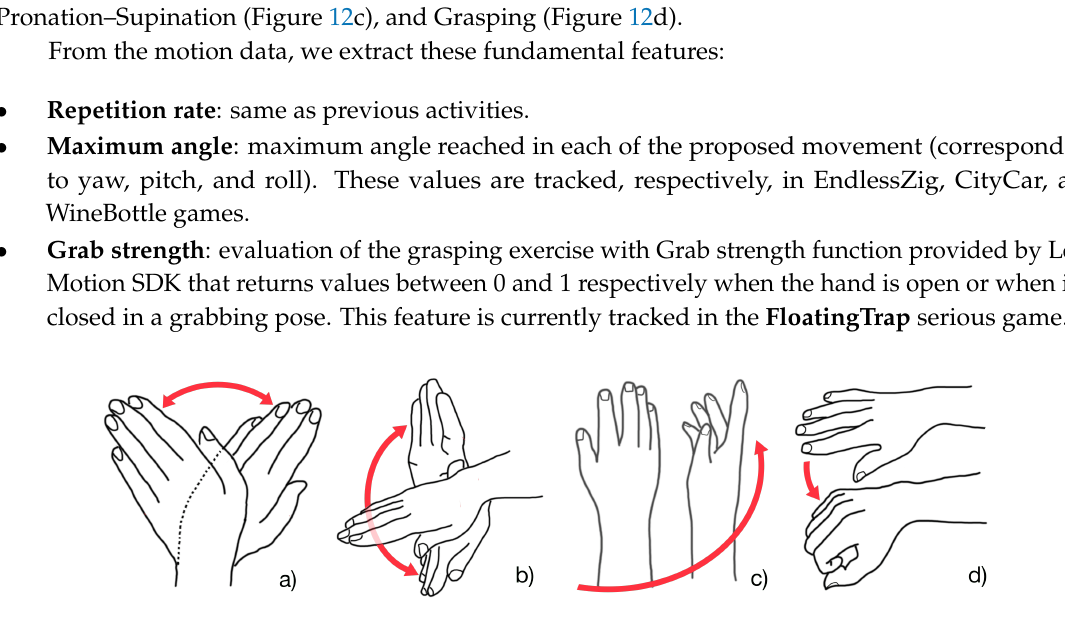
Figure 12. Movements detected during hand rehabilitation with Leap Motion: ( a ) Radial–Ulnar deviation movement in EndlessZig game; ( b ) Flexion–Extension movement in CityCar game; ( c ) Pronation–Supination movement in WineBottle game; ( d ) Grasping movement in FloatingTrap